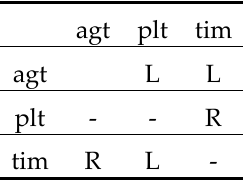
Figure 8. UNL graph for the UNL expression of the sentence with a scope node.